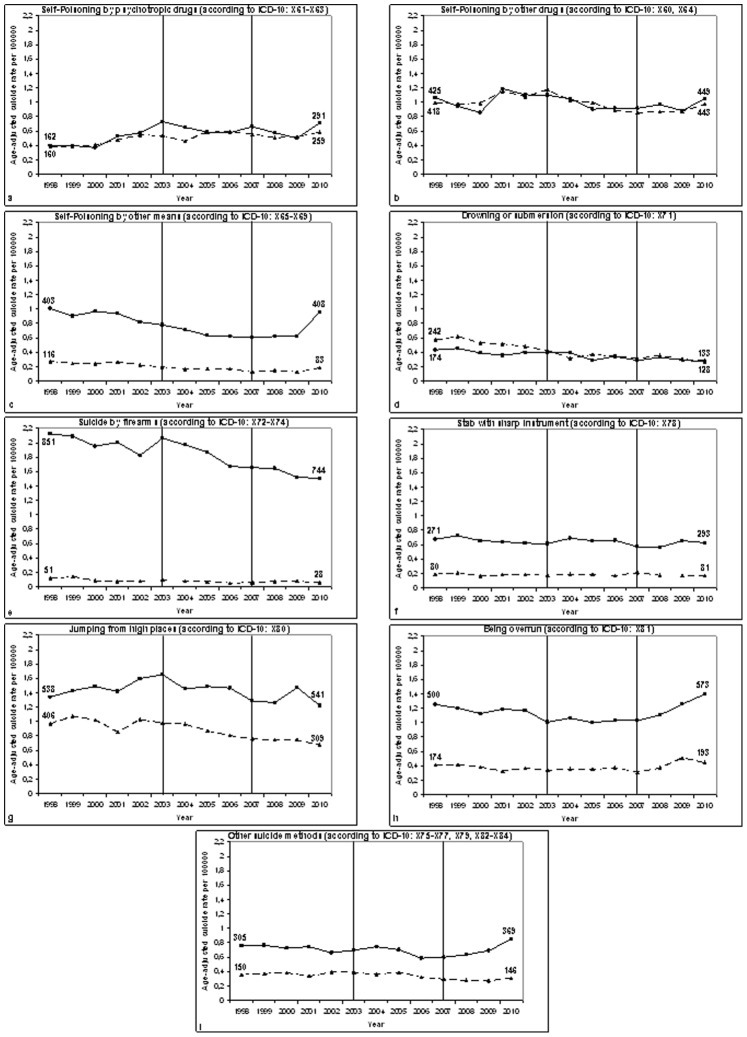
Age-adjusted suicide rates (per 100000 inhabitants) in Germany (1998–2010) for males and females.The rates (reference year: 1998) were stratified for several suicide methods: a) Self-Poisoning by psychotropic drugs (according to ICD-10: X61-X63); b) Self-Poisoning by other drugs (according to ICD-10: X60, X64); c) Self-Poisoning by other means (according to ICD-10: X65-X69); d) Drowning or submersion (according to ICD-10: X71); e) Suicides by firearms (according to ICD-10: X72-X74); f) Stab with sharp instrument (according to ICD-10: X78); g) Jumping from high places (according to ICD-10: X80); h) Being overrun (according to ICD-10: X81); i) Other suicide methods (according to ICD-10: X75-X77, X79, X82-X84). –– Age-adjusted suicide rates for men (with squares); - - - Age-adjusted suicide rates for women (with triangles). Vertical lines represent the joinpoints which had been identified for the overall suicide mortality trends in Germany 1998–2010. The numbers in the figures represent suicide frequencies in males and females, for the years 1998 and 2010, respectively.